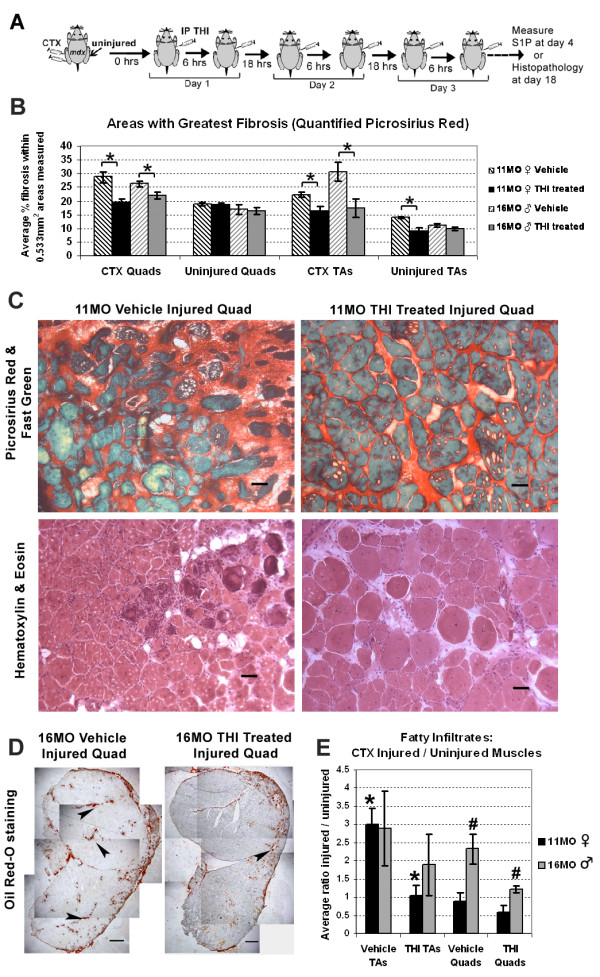
Dystrophic pathology following muscle injury is improved with THI treatment. (A) Experimental schematic of THI (0.075 μg/day) and PBS (vehicle)-treated mdx mice injected IP twice daily for the first 72 hours following CTX injury. Muscles from aged mdx4cv mice (n = 7, THI-treated: 3 × 11-MO females, 4 × 16-MO males; n = 6 vehicle-treated: 3 × 11-MO females, 3 × 16-MO males) were harvested for histopathology analysis 18 days post CTX injury. (B) Histological quantification of picrosirius red staining indicates lower fibrotic accumulation following injury in both TA and quadriceps (quads) muscles from mice treated with THI. For CTX-injected muscles, damaged regions of muscle (for example fields with the greatest accumulation of sirius red staining) were quantified for both THI and vehicle-treated mice. The level of fibrosis was not significantly different between treated and control (vehicle) uninjured quadriceps; however, uninjured TA muscles from 11-MO THI-treated mice had lower fibrosis compared to control TA muscles. For each muscle, three separate sections (200 μm apart in longitudinal distance) were analyzed. (C) Representative photographs of injured quadriceps stained with picrosirius red and fast green depict collagen deposition (red staining), while muscle morphology and organization is depicted with hematoxylin and eosin staining. Scale bars = 50 μm. (D) Oil Red O staining depicts fat deposits (arrows) over the entire CSA of THI-treated and vehicle-injured quadriceps from 16-MO males. Scale bars = 500 μm. (E) The ratio of fat deposition in injured TAs over uninjured contralateral TAs quantified from Oil Red O staining was significantly reduced in THI-treated versus control animals in 11-MO (*) but not 16-MO mdx4cv mice. In contrast, the ratio of injured over uninjured fat deposits in quadriceps was significantly reduced in 16-MO (#) but not in 11-MO mdx mice. *P <0.05, **P <0.01 by student’s t-test. Error bars represent SEM. CSA, cross-sectional area; CTX, cardiotoxin; IP, intraperitoneal; MO, month-old; SEM, standard error of the mean; TA, tibialis anterior; THI, 2-acetyl-4(5)-tetrahydroxybutyl imidazole.